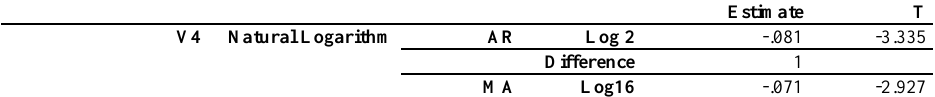
Table 13. The parameters of ARIMA by studying the studied factors in work.